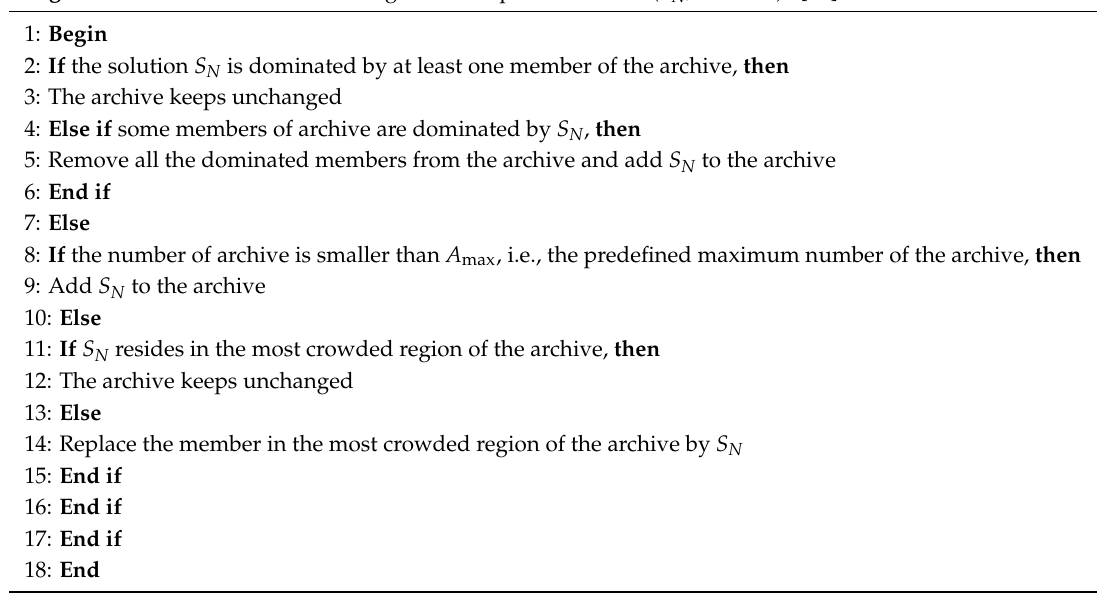
Algorithm 1 The Pseudo-Code of Algorithm “Update_Archive ( S N , Archive)”